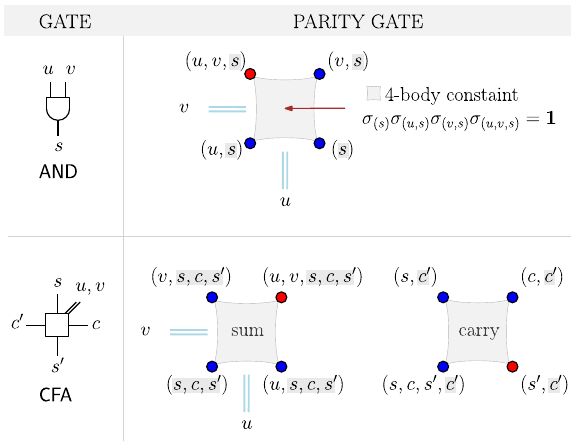
Fig. 3 Parity gates. AND and CFA gates are implemented via ground state coding on four or eight qubits, respectively [see Fig. 2c]. While individual physical qubits encode parity information (denoted by the tuple, e.g., σ fi ned by local fi elds (red + 1 and blue − 1) and ( u , v , s ) ), the gates are de 4-body constraints ∏ ω ∈ σ ω = 1 as additional penalty term (highlighted by gray squares). Thus, the operator H AND is implemented on a single parity plaquette. Conversely, the Hamiltonian H CFA is implementable by means of two parity plaquettes denoted by “ sum ” and “